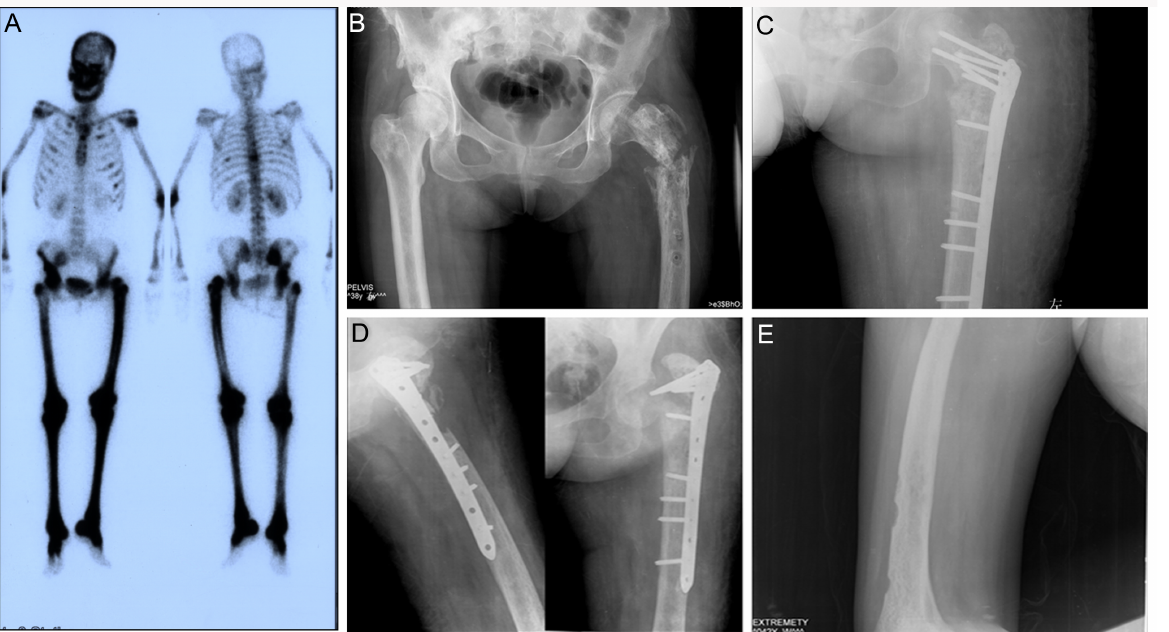
Figure 7. Patient 6: ( A ) 99m Tc-MDP bone scan showed increased uptake in the metaphyses and diaphyses of long bones, iliac bones and ribs. ( B ) Subsequent X-ray examination of pelvis revealed fracture near greater trochanter of the left femur. Postoperative X-ray examination ( C ) and X-ray examination performed 3 years after the internal fixation surgery ( D ) demonstrated disunion of the fractured femur. ( E ) X-ray of the left femur revealed diffuse osteosclerosis with focal osteolysis in the diaphysis and metaphysis of the distal right